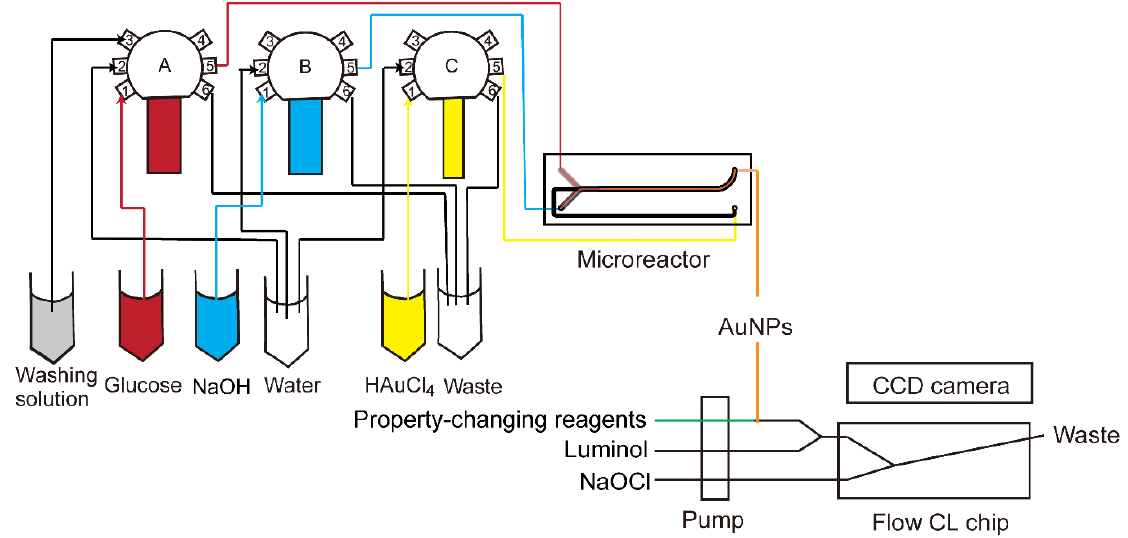
Figure 3. Scheme of online synthesis and CL characterization system. The synthesis was controlled automatically by Matlab. Reagents were supplied to the microreactor via three glass syringes connected to a 6-port valve. Synthesized AuNPs were mixed with property-changing reagents, luminol and NaOCl in a microchip to generate a CL signal which was recorded by CCD camera.